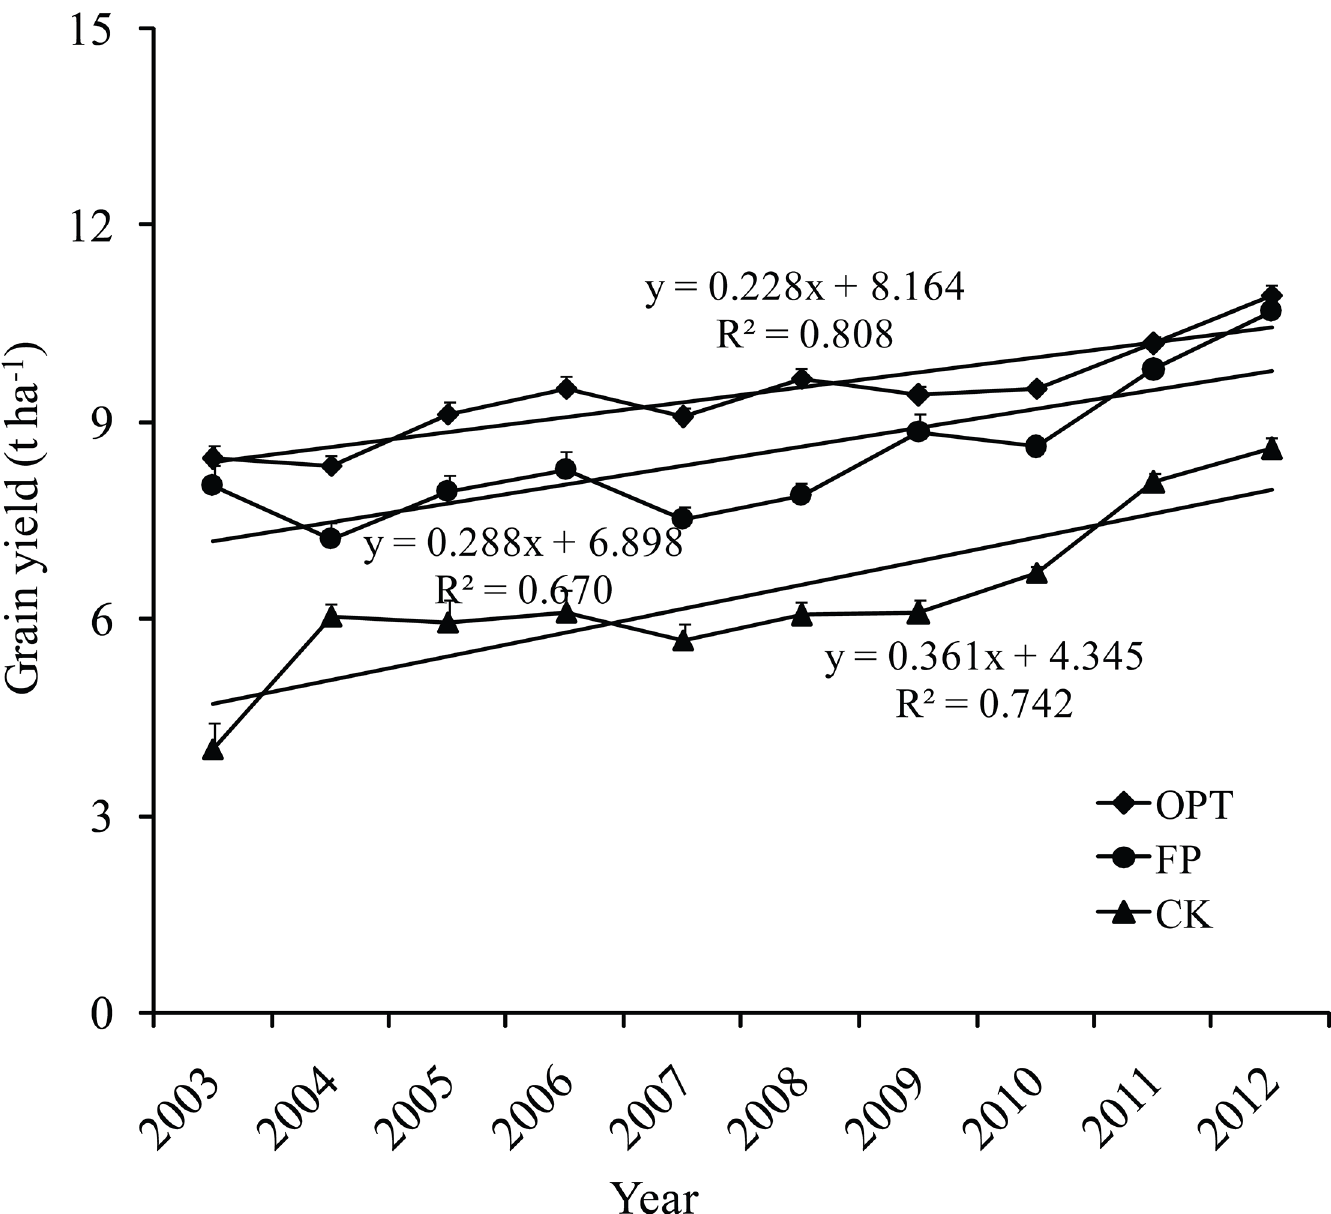
Fig 2. Trend in grain yield for optimal management (OPT), farmers ’ practice (FP), and control treatment without fertilization (CK) in the past decade across in maize grown regions in China. Yield data come from experiments collected by our research group from 2003 to 2012, error bars represent standard